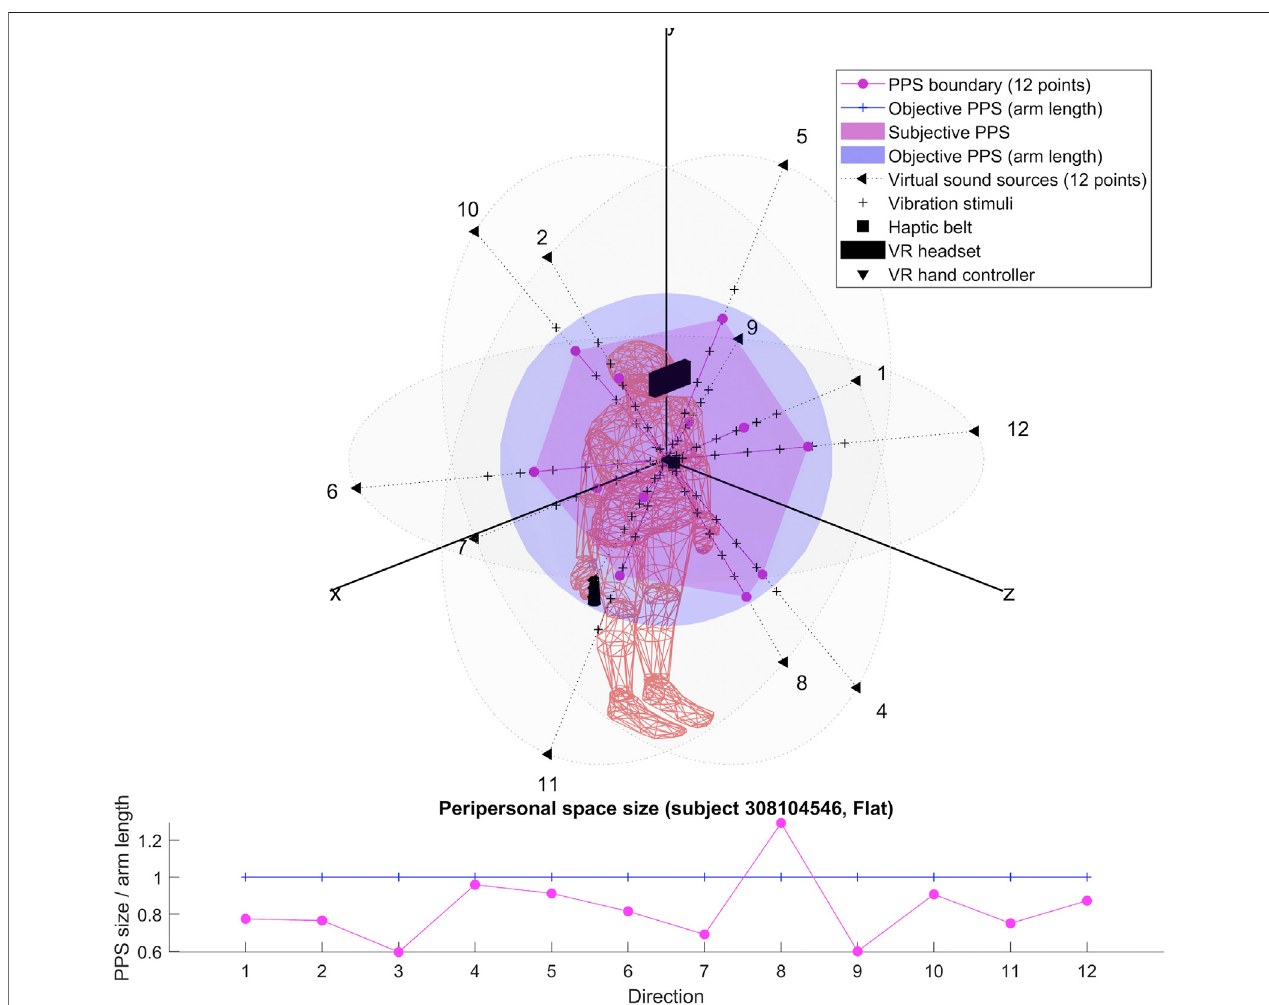
FIGURE 5 | PPS 3D representation for subject 308104546 fl at